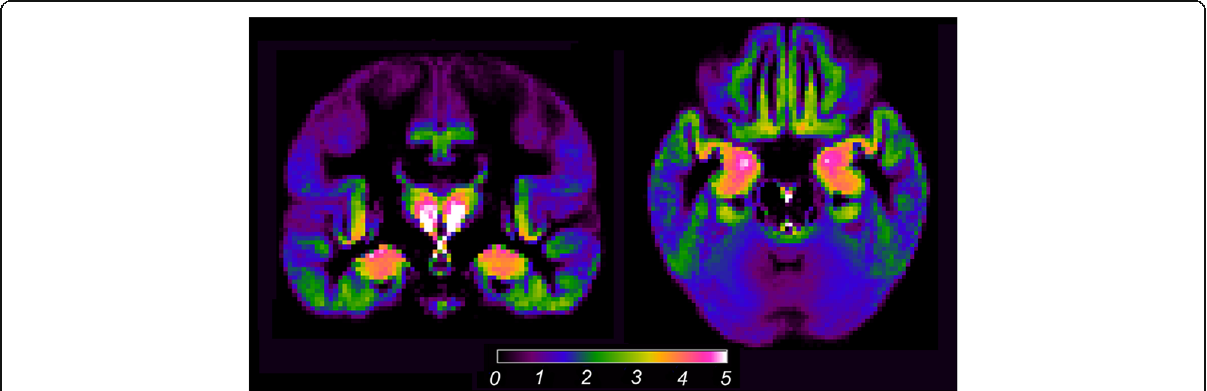
Fig. 1 Mean SUVR images of 18 F-THK5351 in cognitively normal older adults. Localized 18 F-THK5351 accumulation was mainly evident in the basal ganglia, thalamus, and medial temporal lobe, which slightly extended to the inferior temporal lobe, insula, posterior cingulate gyrus/precuneus, and basal frontal lobe. SUVR, standardized uptake value ratio